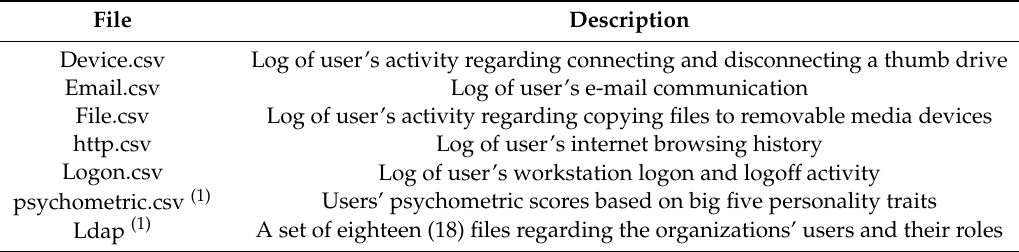
Table 1. Insider threat dataset r4.2 files’